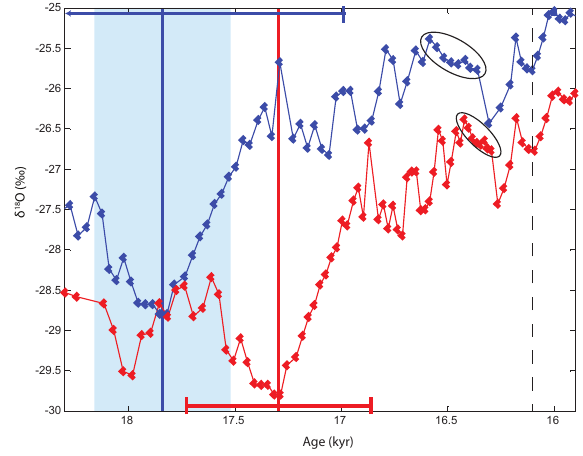
Figure 8. Detail of Law Dome δ 18 O record on the Pedro et al. (2011) timescale (blue) and on ALT timescale (red and shifted down by 1‰). Black vertical dashed line is the depth–age tie point. Blue vertical line and shading are the respective timing and un- certainty of the onset of deglacial warming defined by Pedro et al. (2011). The red vertical line marks the timing of the onset of deglacial warming with ALT. The blue horizontal bar is increased uncertainty by adding an interpolation uncertainty appropriate for linear interpolation. The red horizontal bar is the total uncertainty for the ALT timescale. See text for description of uncertainty calcu- lations. The two circled areas show the different durations of climate events that can result from using different interpolation methods. The duration of the cooling with ALT is about half its duration with linear